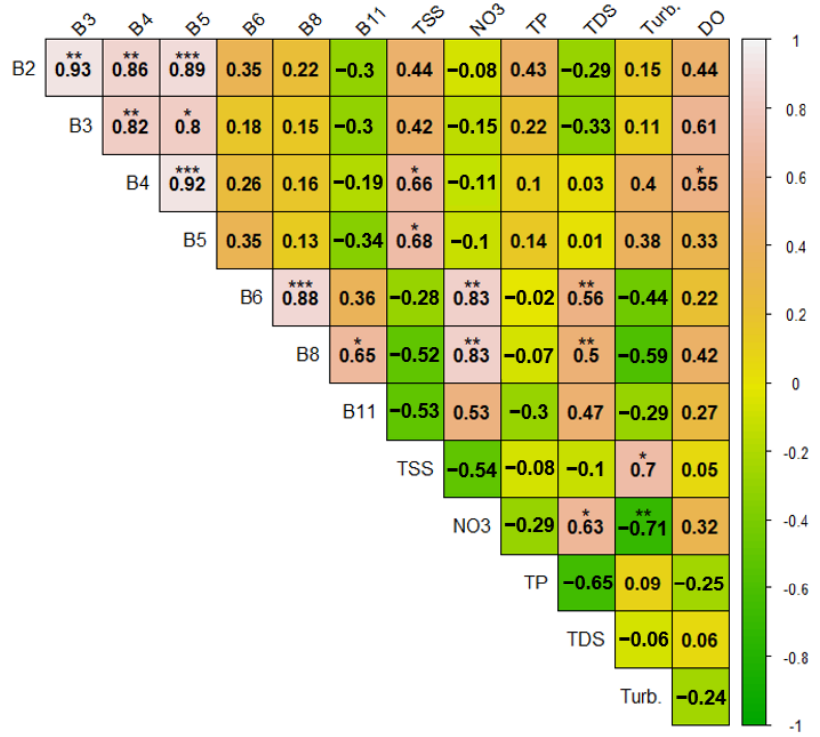
Figure 2. Spearman correlation correlogram; significance values at *** p < 0.001, ** p < 0.01, * p < 0.05.